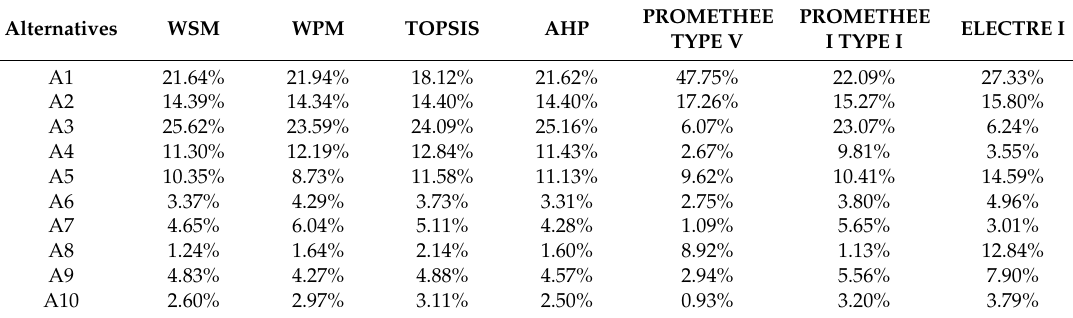
Table 7. Stochastic WSM, TOPSIS, AHP, PROMETHEE I and ELECTRE I results.